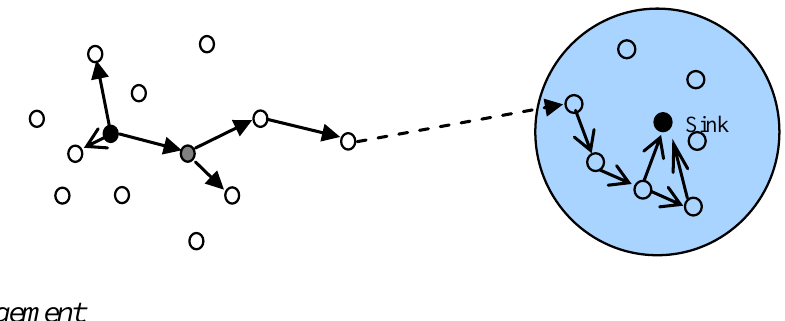
Figure 3. Sketch of the routing